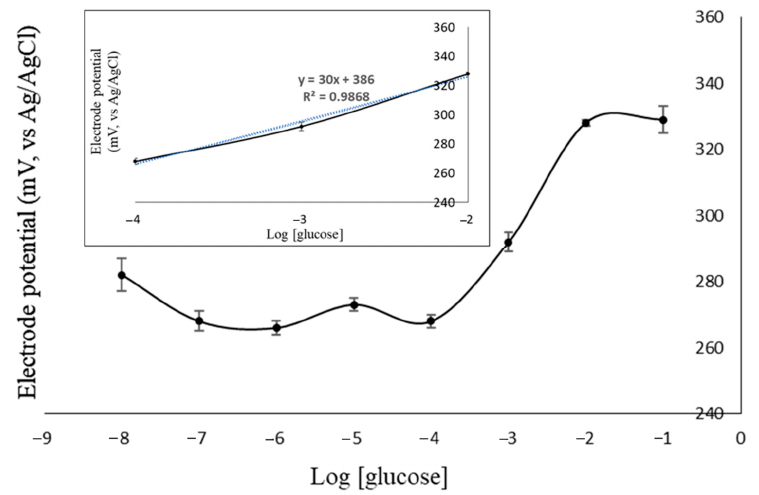
Figure 7. The correlation of log [glucose] with electrode potential (inset: the linearity curve of the E2 electrode).